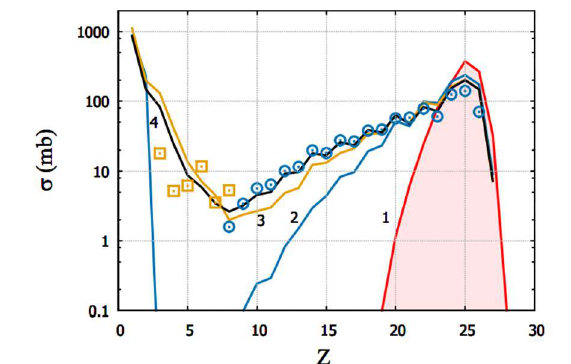
Figure 3. (Color online) Symbols show the experimental spallation residue Z-distribution [4] and emitted IMFs [5] in 𝐹𝑒 (cid:2873)(cid:2874) + 𝑝 reactions at 1.0 GeV/A. Solid curves show the calculated distribution with ISABEL (curve 1) and ISABEL- MECO (curves 2, 3 and 4) using various assumptions for the number of equilibrium decay channels described in the